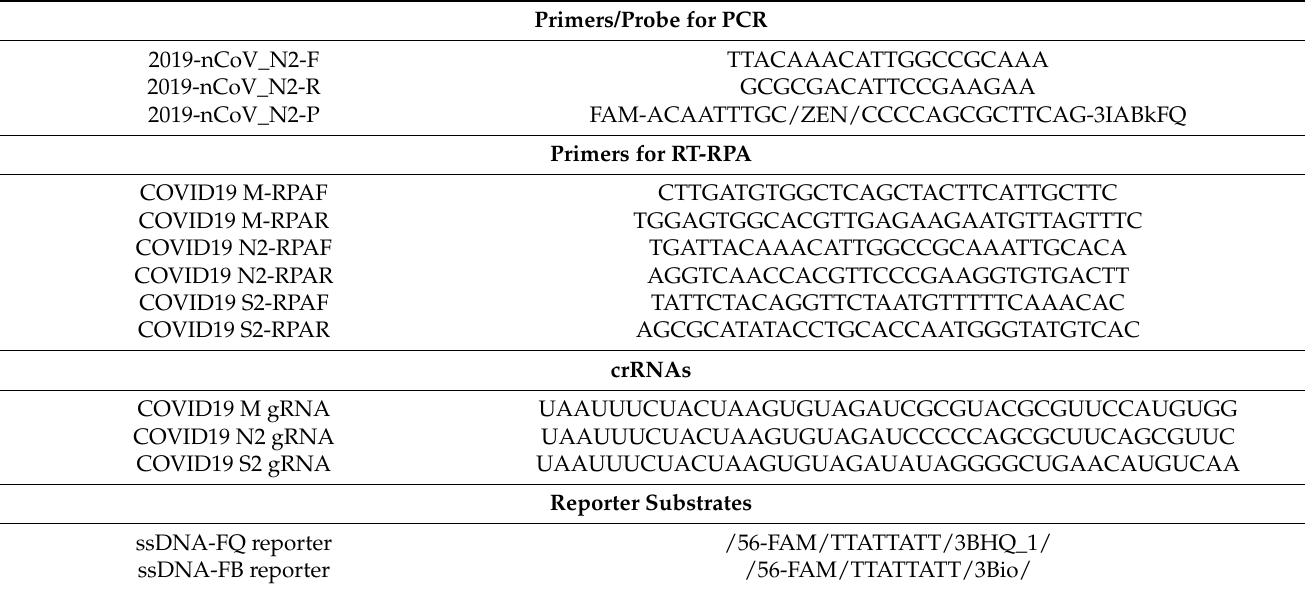
Table 1. Sequences for RPA primers, PCR primers/probes, guide RNAs (crRNAs), and reporter substrates. Primers/Probe for PCR